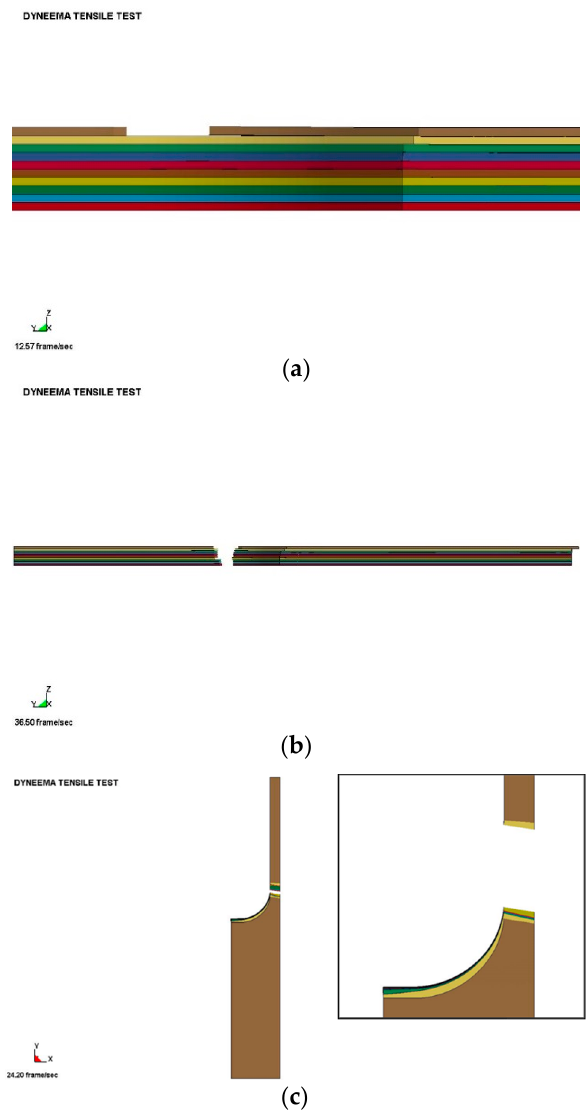
Figure 18. Finite Element model with ten layers. ( a ) Partial failure; ( b ) Complete failure; ( c ) Complete failure and slippage (insert showing close ‐ up).